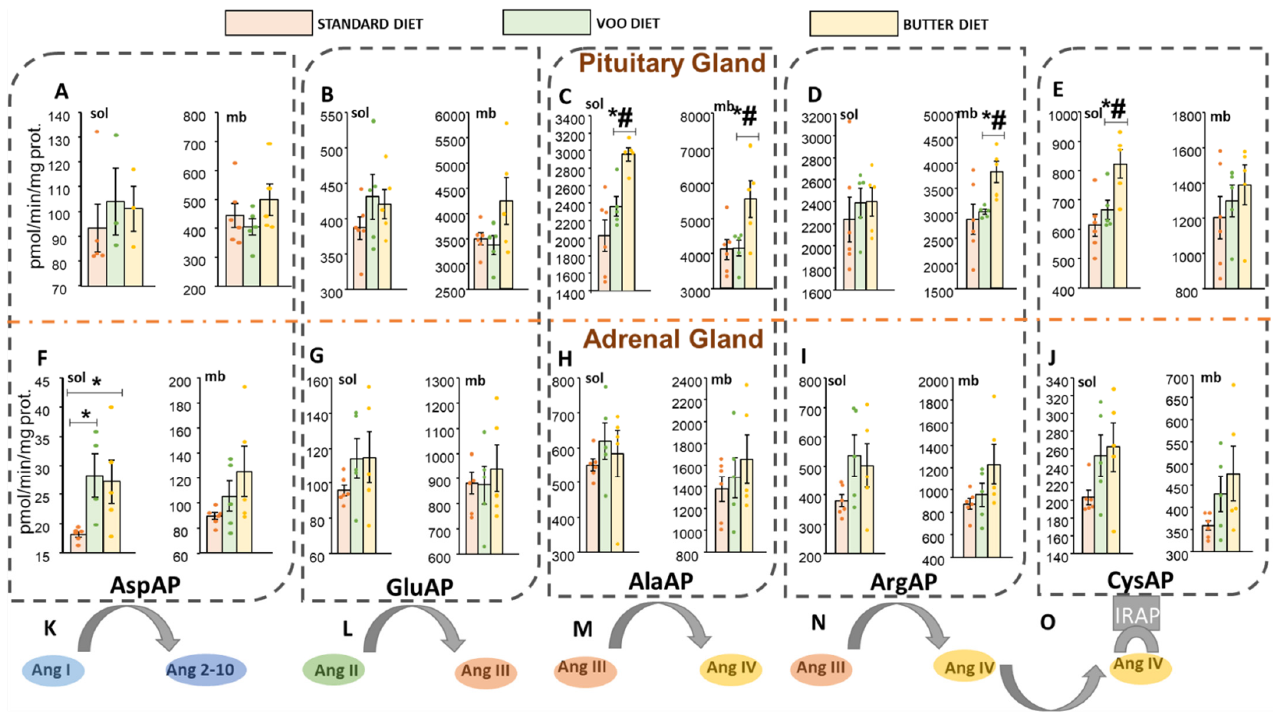
Figure 2. Angiotensin metabolism by angiotensinase activities. ( K ) Scheme of the metabolic conversion of angiotensin I (Ang-I) to angiotensin 2–10 (Ang 2–10) by the action of Aspartyl-aminopeptidase (AspAP). AspAP activity in the soluble (sol) and membrane-bound (mb) fractions of the ( A ) pituitary and ( F ) adrenal glands. ( L ) Scheme of the metabolic conversion of angiotensin II (Ang-II) to angiotensin III (Ang-III) by the action of Glutamyl-aminopeptidase (GluAP). GluAP activity in the sol and mb fractions of the ( B ) pituitary and ( G ) adrenal glands. ( M , N ) Scheme of the metabolic conversion of angiotensin III (Ang-III) to angiotensin IV (Ang-IV) by the action of Alanyl-aminopeptidase (AlaAP) and arginyl-aminopeptidase (ArgAP). AlaAP and ArgAP activities in the sol and mb fractions of the ( C , D ) pituitary and ( H , I ) adrenal glands. ( L ) Cystinyl- aminopeptidase activity (CysAP), also called insulin-related aminopeptidase (IRAP). Scheme of the binding of angiotensin IV (Ang-IV) to its ang-IV receptor (AT4) ( O ), which in turn is CysAP, with the ability to hydrolyze oxytocin and vasopressin. CysAP activity in the sol and mb fractions of the ( E ) pituitary and ( J ) adrenal glands. S: standard diet; VOO: diet enriched with virgin olive oil; Bch: diet enriched with diets and cholesterol. The activities were expressed as picomoles of β - naphthylamide per minute per milligram of protein (pmol/min/mg prot.). * p -value < 0.05, compared to standard diet (S). # p -value < 0.05, compared between HFD (VOO vs.